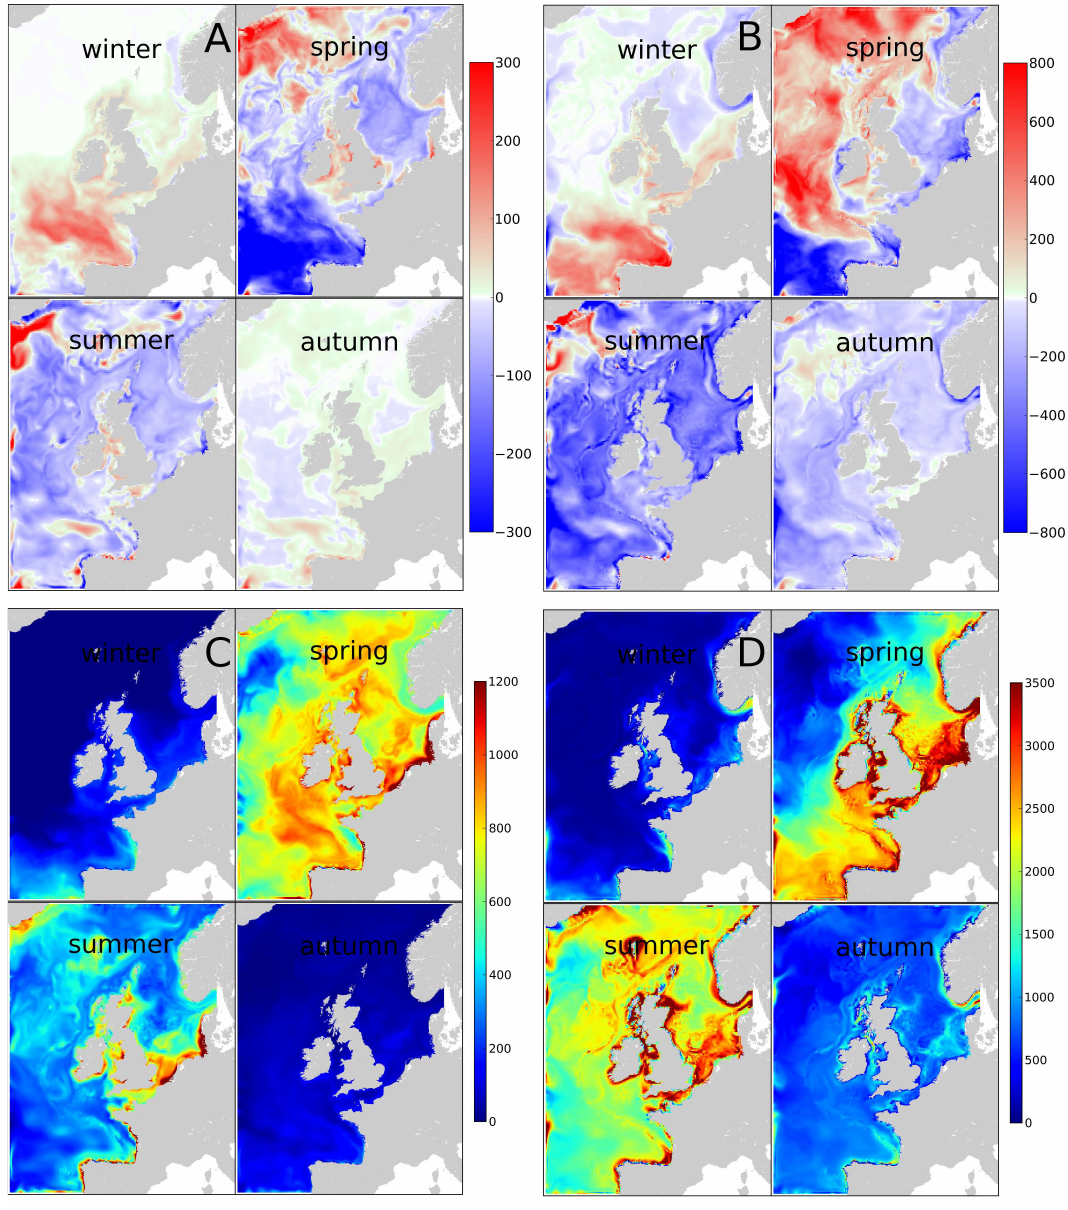
Fig. 4. Impacts of climate change and OA in the ecosystem as projected by the A1B scenario (A1B minus PD scenarios). (a) difference in net primary production (depth integrated, mgCm − 2 d − 1 ) , (b) difference in zooplankton biomass (depth integrated, mgCm − 2 ) . Reference values of the seasonal mean of net primary production (c) and zooplankton biomass (d) are also shown.